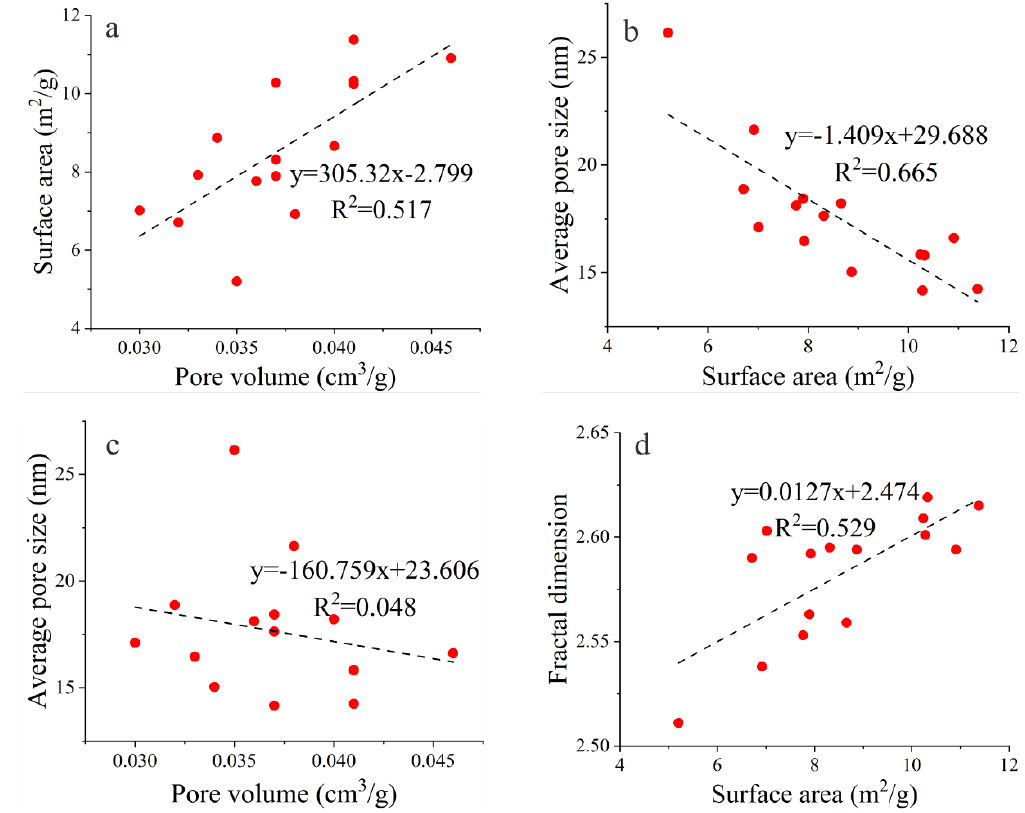
Figure 11. Relationships between pore volume and surface area ( a ), surface area and average pore size ( b ), pore volume and average pore size ( c ), surface area and fractal dimension ( d ).